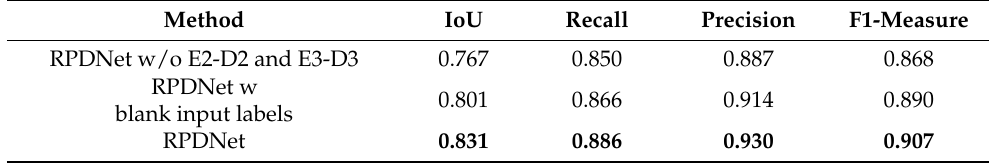
Table 4. Quantitative results of ablation experiments. w/o and w stand for without and with.